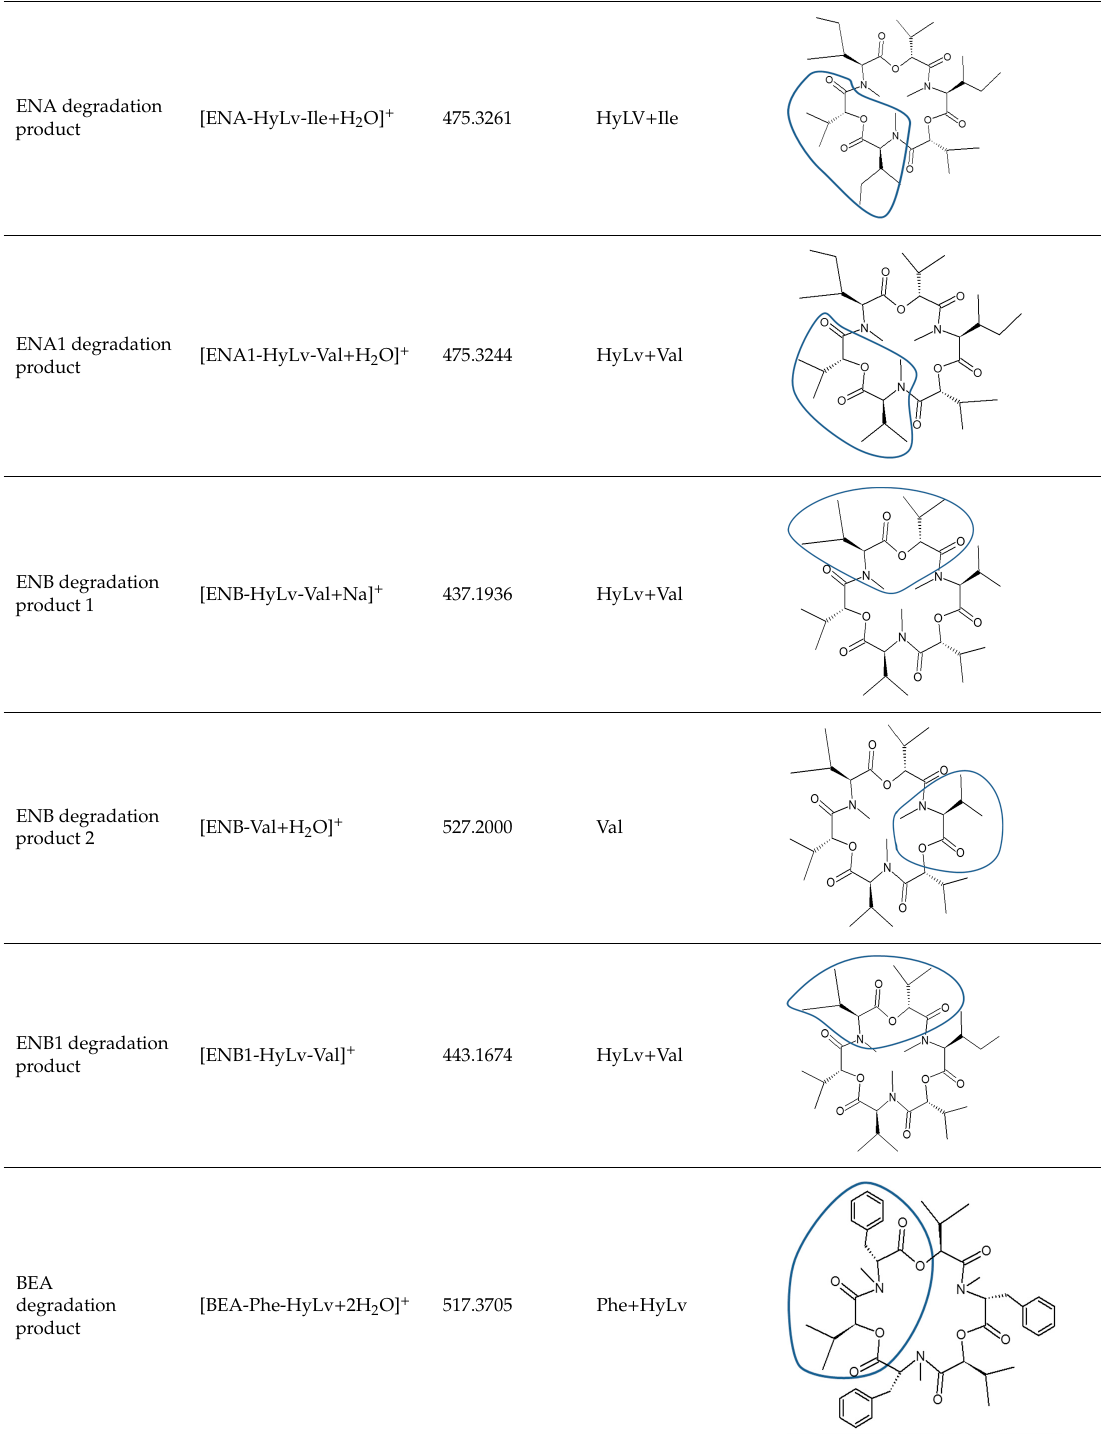
Figure 4. LC-ESI-qTOF-MS chromatogram of degraded product ENB1 m/z 443.1674 obtained in matrix samples after PEF treatment. 3.3. In Silico Prediction Methods In silico prediction methods were used in this work to evaluate the toxicity of detected and identified degradation products by using the ProTox-II web server. Results of oral acute toxicity expressed as LD50 (mg/Kgbw) and the corresponding toxicity class for each identified compound are shown in Table 2. It should be highlighted that, according to the obtained predictions, both ENB degradation products showed a predicted LD50 of 3 mg/Kgbw, both with 100% average similarity and prediction accuracy. Thus, the assigned toxicity class was I. According to this result, special attention should be paid to those degradation products, as their predicted toxicity is comparable to that of ENB and also T-2 Toxin (Table 2), which is known to be a toxic fungal metabolite with the lowest tolerable daily intake (TDI) within the Fusarium mycotoxins [32]. Using the ProTox-II web server, the organ toxicity can be also predicted, specifically the hepatotoxicity, which has been evaluated for different identified compounds, as the liver is the organ where mycotoxins are metabolized. The results obtained regarding the organ toxicity and also the calculated predictions for diverse toxicological endpoints using the ProTox-II web server are reported in Table 3. These results showed that identified degradation products were predicted as inactive compounds for hepatotoxicity. However, the ENB1 degradation product was predicted as an active compound for an immunotoxicity endpoint, although the percentage of prediction accuracy (probability score) was low (51%). The prediction results obtained for the toxicological pathways, nuclear receptor signaling pathways, and stress response pathways are reported in Tables 4 and 5, respectively. According to the Tox21 Consortium, chemical compounds might have the potential to disrupt processes in the human body, which may lead to negative health effects [23]. Regarding the nuclear receptor